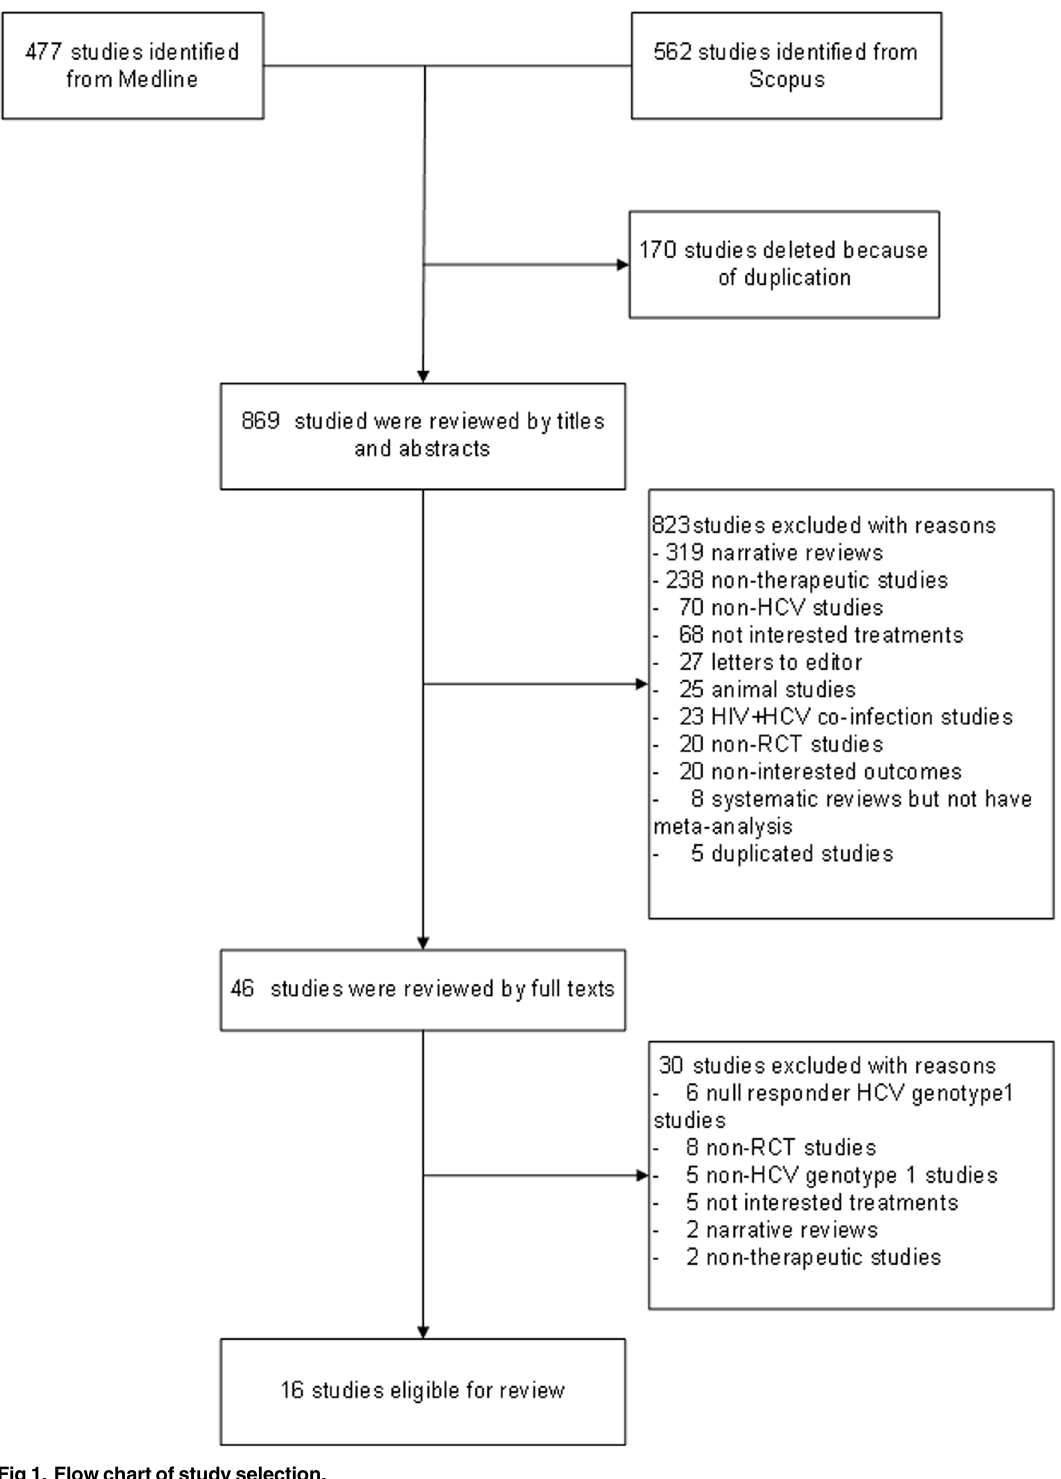
PLOS ONE | DOI:10.1371/journal.pone.0145953 December 31,